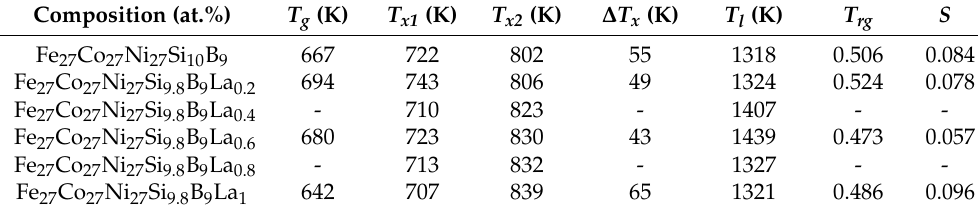
different temperatures. Figure 2c shows the XRD patterns of Fe 27 Co 27 Ni 27 Si 10 − x B 9 La x ( x = 0,